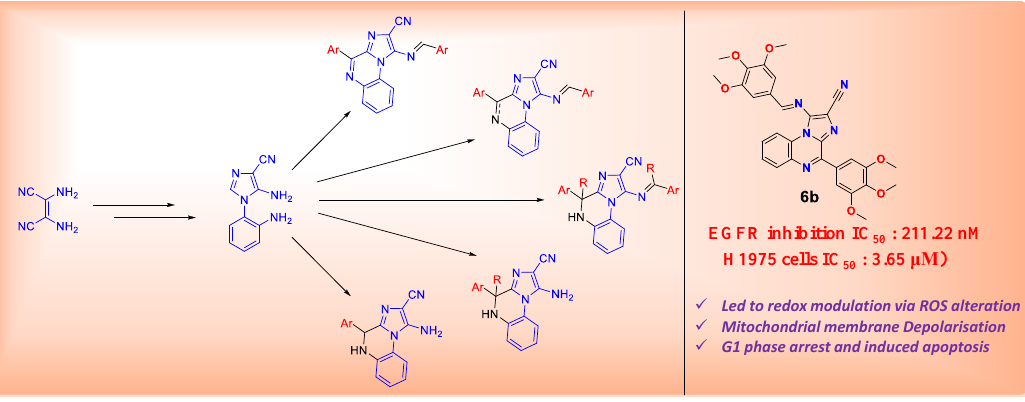
Figure 30. Target compounds 5–10 .